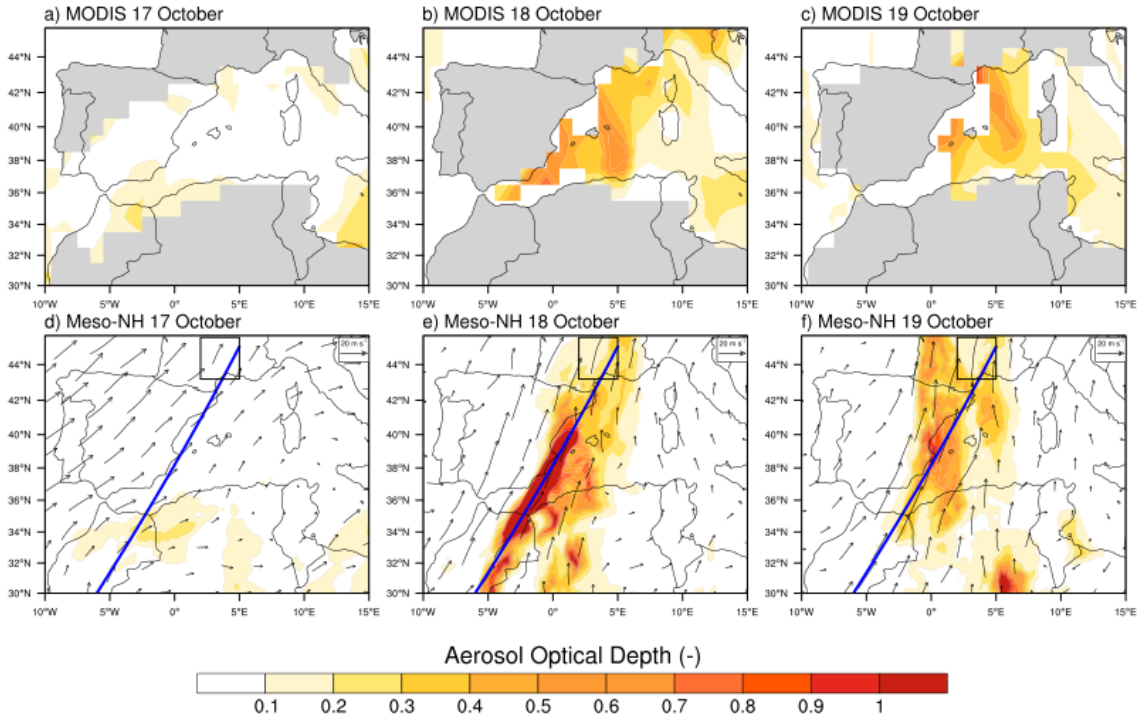
Figure 4. Top panels: MODIS Aqua-derived AOD at 13:30UTC on (a) 17 October, (b) 18 October and (c) 19 October 2012. Meso-NH DUST simulation of AOD at 12:00UTC on (d) 17 October, (e) 18 October and (f) 19 October 2012. Bottom panels: the simulated horizontal wind field at 3kma . m . s . l . (vectors) is superimposed on panels (d–f) with the scale of the vectors given in the upper right corner of the panels. The blue solid line indicates the position of the vertical cross sections shown in Fig. 8. The black box shows the CV area.